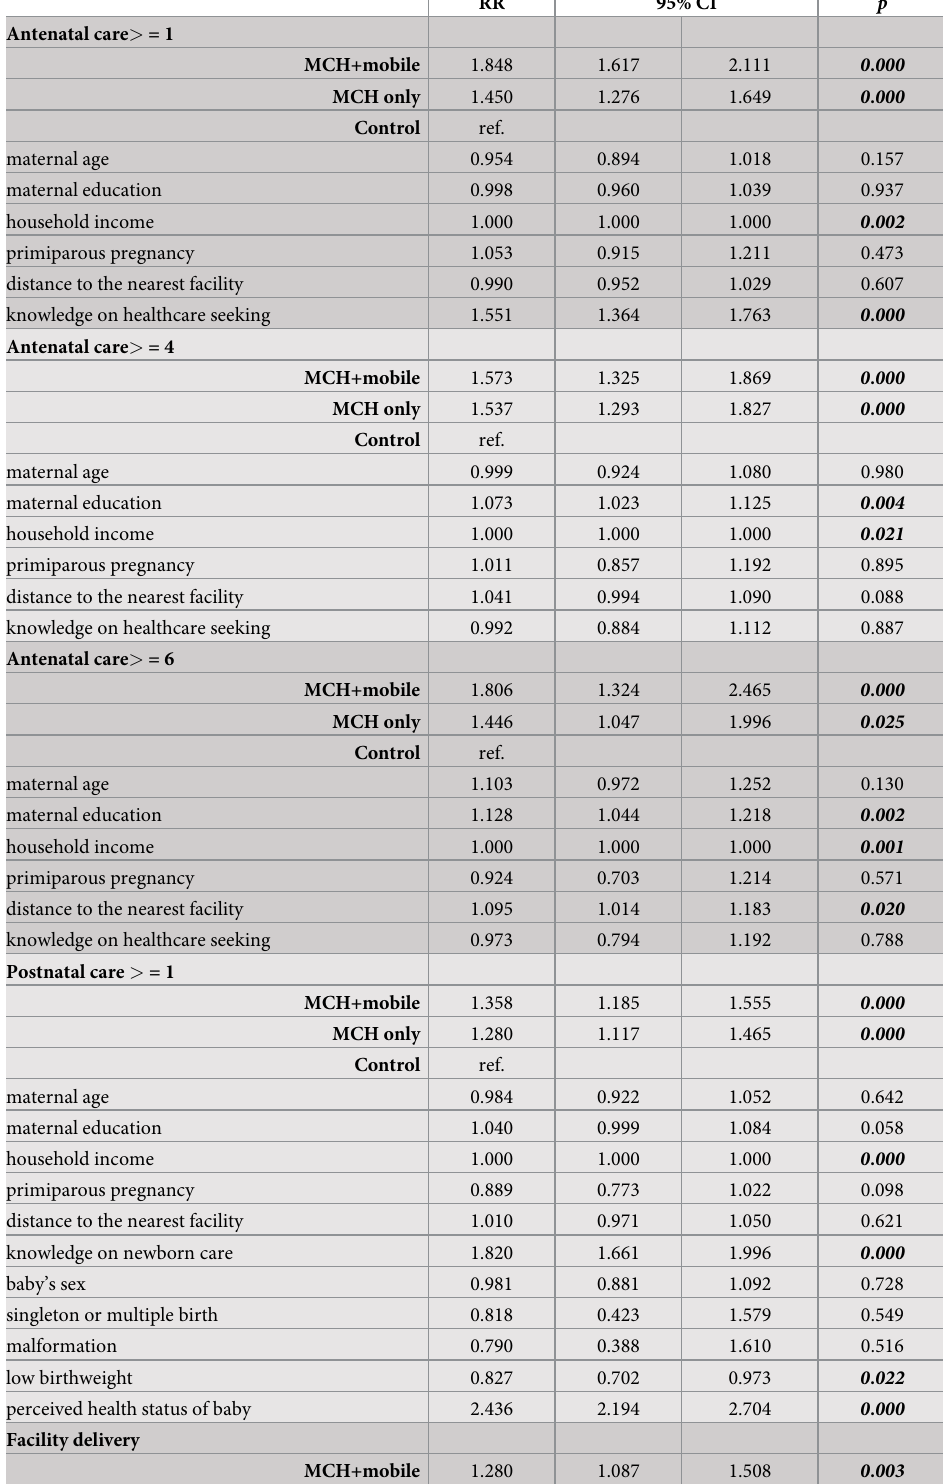
Table 3. Multivariate analysis (GEE) for effects of the interventions on the expected outcomes.